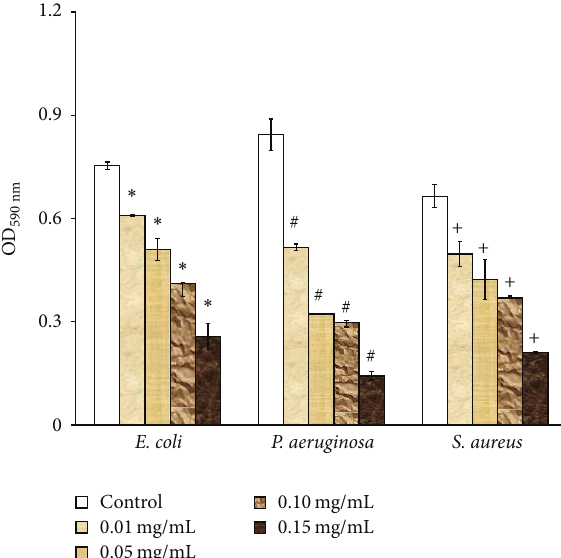
Figure 4: Optical density measurements of 24 h biofilm growth on pluronic coated TCPS surface in the presence of different concen- trations (0.01mg/mL, 0.05 mg/mL, 0.10 mg/mL, and 0.15 mg/mL) of iron-oxide nanoparticles. ∗ Significant difference at 𝑃 < 0.05 com- pared to control (absence of iron-oxide nanoparticles). # denotes significant difference at 𝑃 < 0.05 compared to control (absence of iron-oxide nanoparticles) and + denotes significant difference at 𝑃 < 0.05 compared to control (absence of iron-oxide